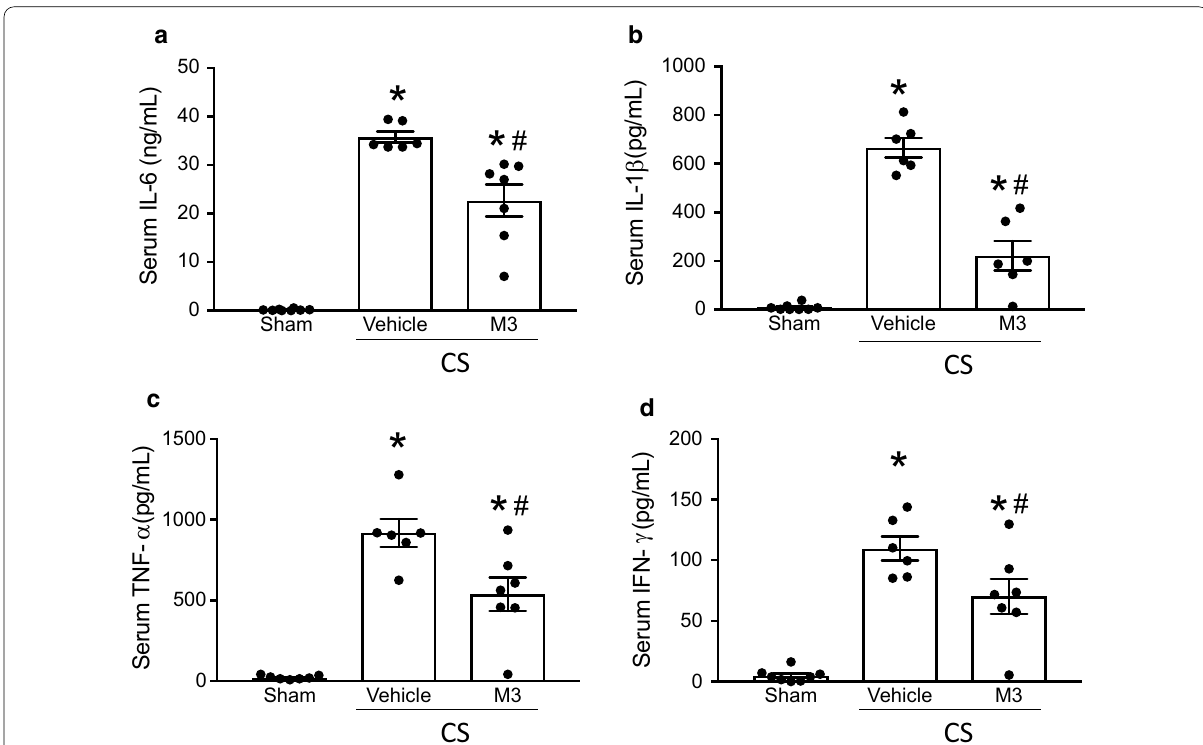
Fig. 2 Treatment with M3 reduces proinflammatory cytokines in neonatal sepsis. 16 h after CS injection, serum from sham, vehicle, or M3 treated pups was collected to measure serum cytokines a IL‑6, b IL‑1β, c TNF‑ ⍺ , and d IFN‑γ by ELISA. Data are expressed as means vehicle 6, and M3 7 pups). Multiple groups were compared by one‑way ANOVA and Tukey method (*p < 0.05 vs. sham; # p < 0.05 vs. Vehicle) = =